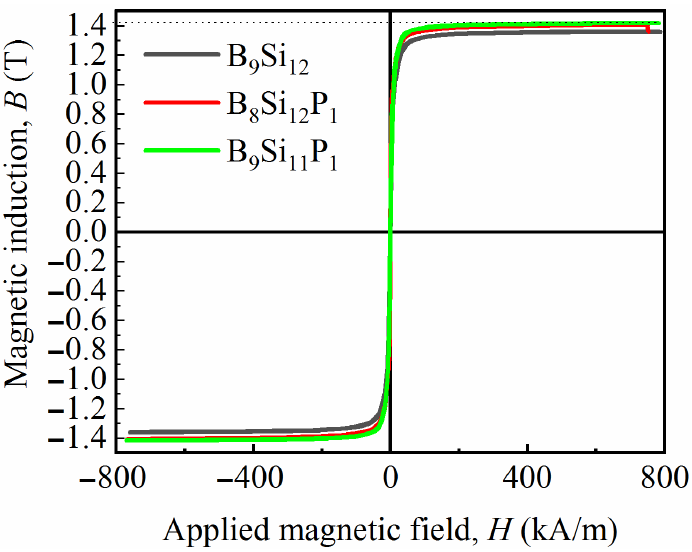
Figure 5. Typical hysteresis loops of B 9 Si 12 , B 8 Si 12 P 1 and B 9 Si 11 P 1 ribbons annealed at 550 °C for 60 min.